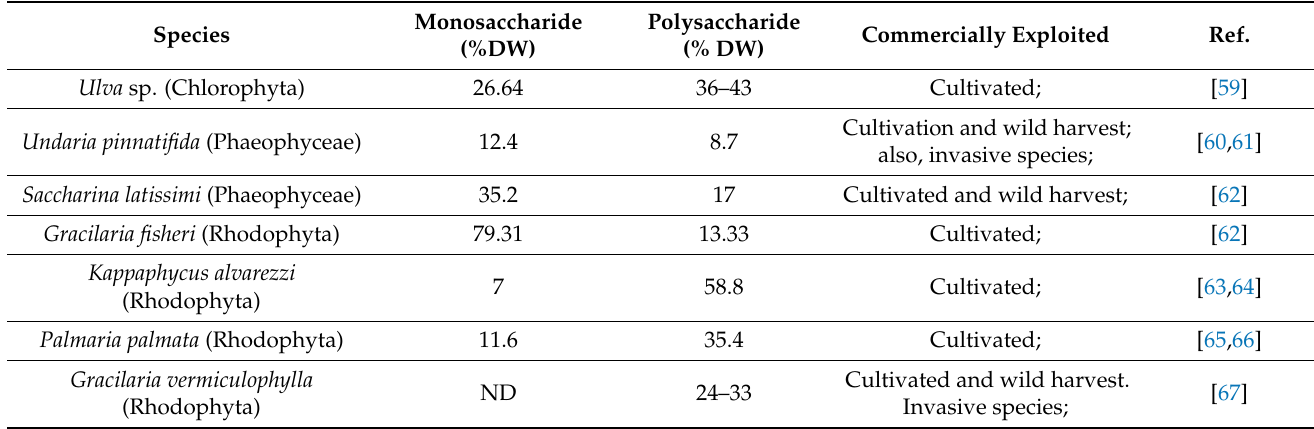
Table 2. Monosaccharide and polysaccharide percentages of example seaweeds used in fermentation processes and their commercial